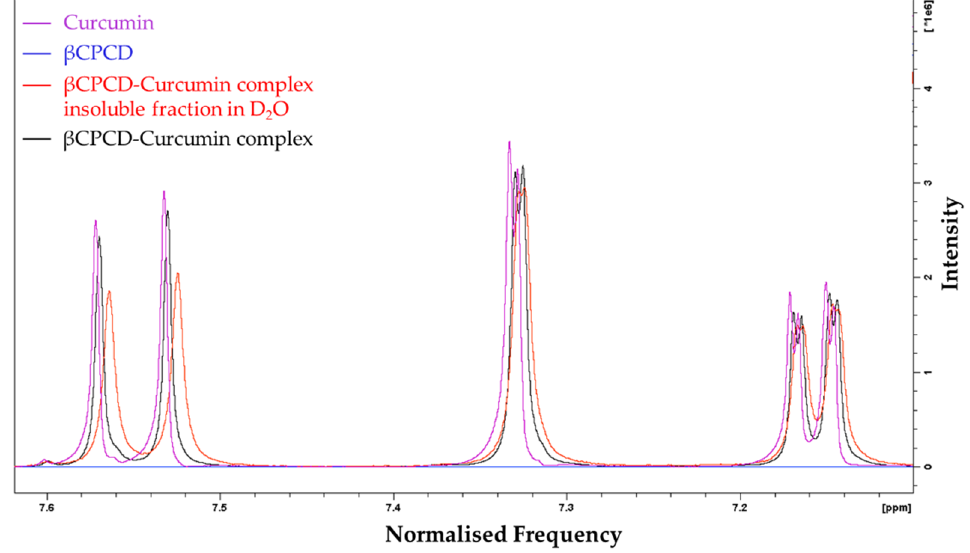
Figure 5. Comparison of 1 H NMR spectra, in DMSO-d 6 of curcumin (purple), β CPCD (blue), insoluble fraction in D 2 O of β CPCD–curcumin mixture (red) and β CPCD–curcumin mixture (black) at 7.60–7.10 ppm.